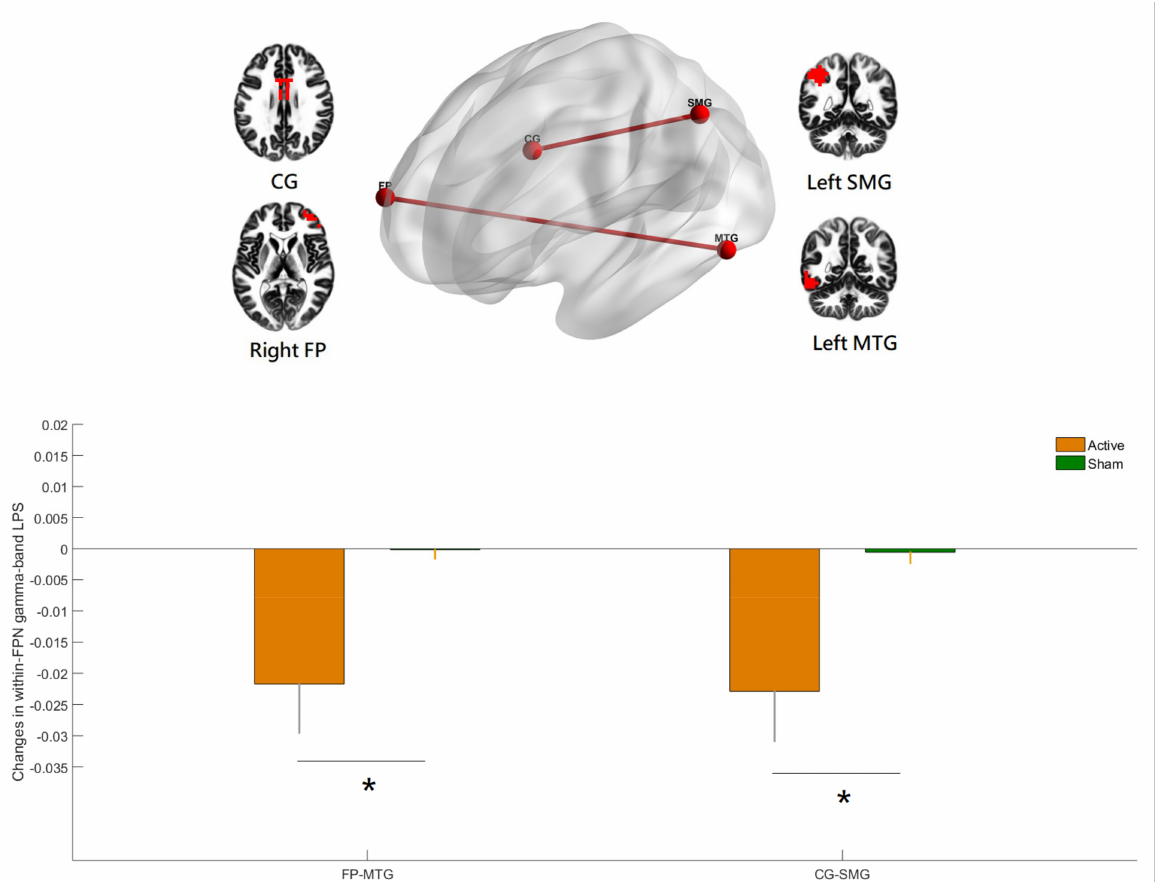
Figure 4. Relative to the sham, the hf-tRNS group had significant decreases in gamma-band within- network lagged phase synchronization (LPS) in the fronto-parietal network (FPN) from baseline to the end of stimulation (all p values < 0.05, corrected) , specifically, between the right frontal pole (FP) and the left middle temporal gyrus (MTG) and between the left supramarginal gyrus (SMG) and the cingulate gyrus (CG). The figure was created using eLORETA and BrainNet Viewer. Regions of interest (ROIs) shown here are displayed on a 5 × 5 × 5 MNI template brain in eLORETA for analyses (5 mm resolution is used). Error bars indicated standard errors. * p < 0.05